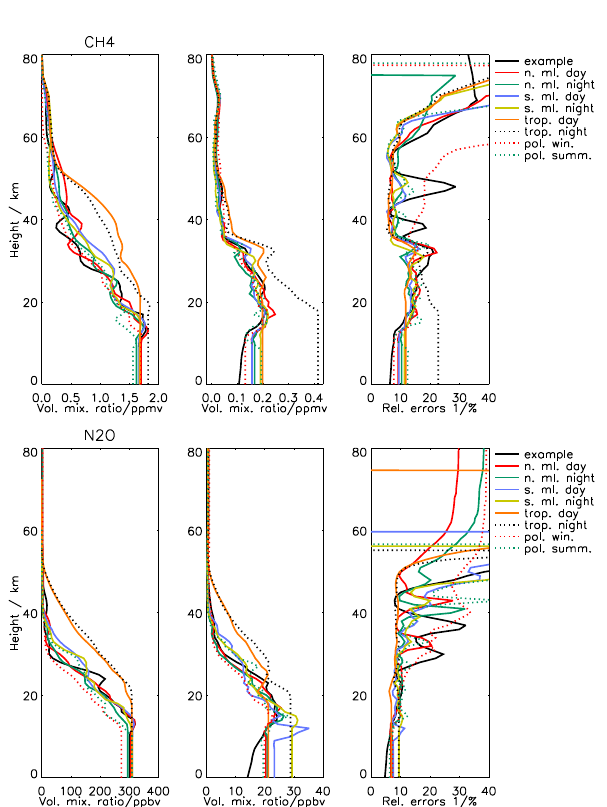
Figure 16. As Fig. 15, but for profiles measured during the full- resolution